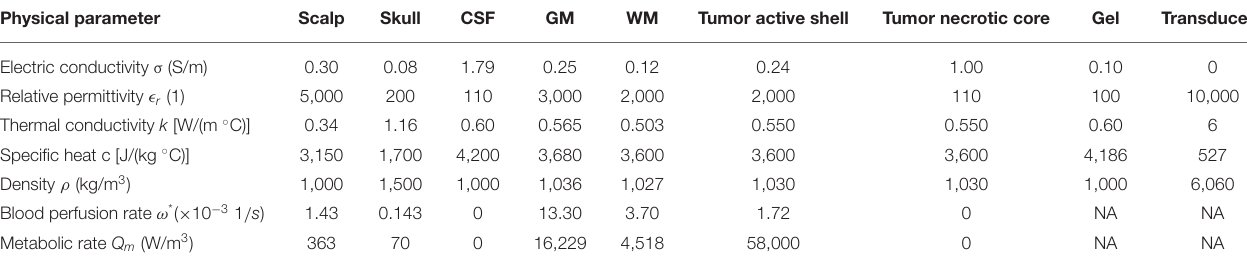
TABLE 1 | Values assigned to the physical properties of each tissue and material. Physical parameter Scalp Skull CSF GM WM Tumor active shell Tumor necrotic core Gel Transducers Electric conductivity σ